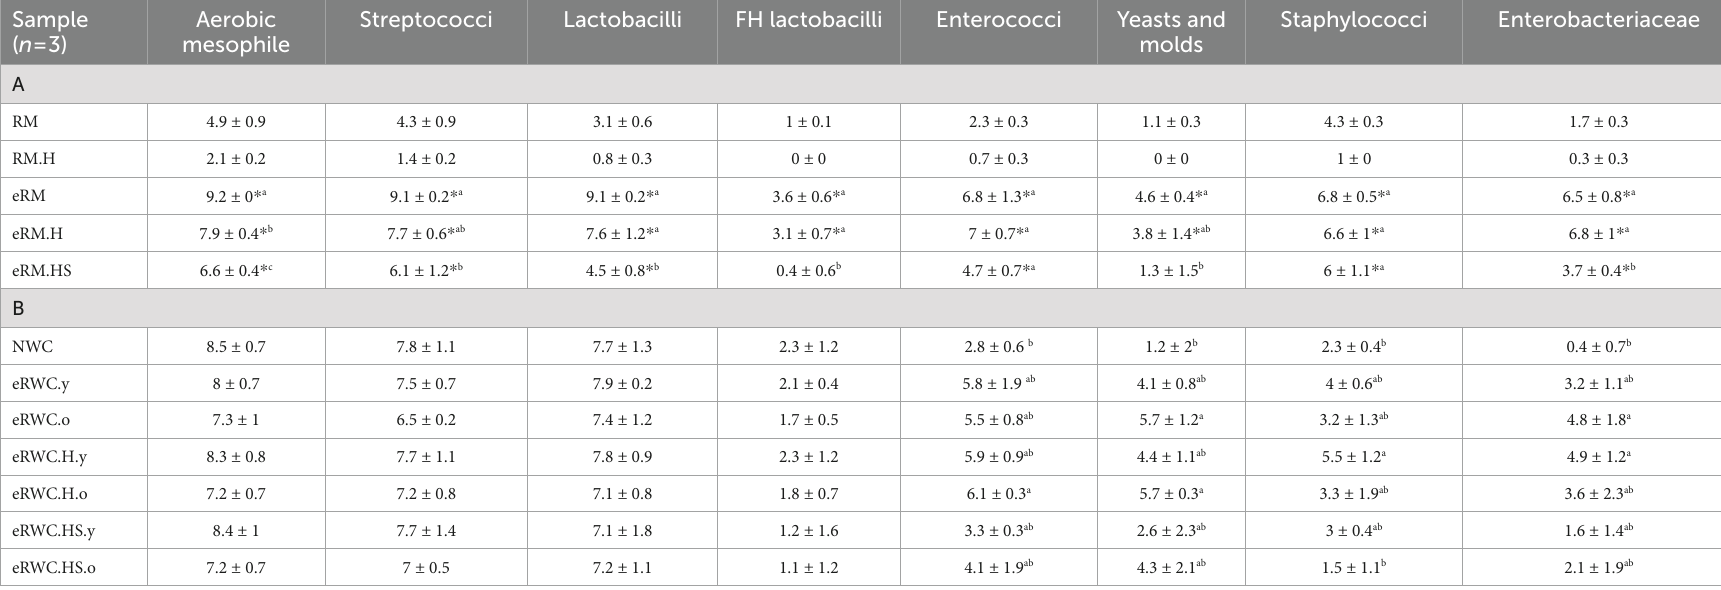
TABLE 2 Viable microbial counts results (mean ±